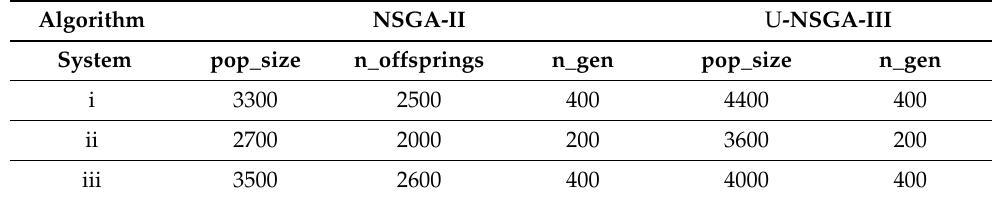
Table 2. Parameter setting in NSGA-II and U-NSGA-III.